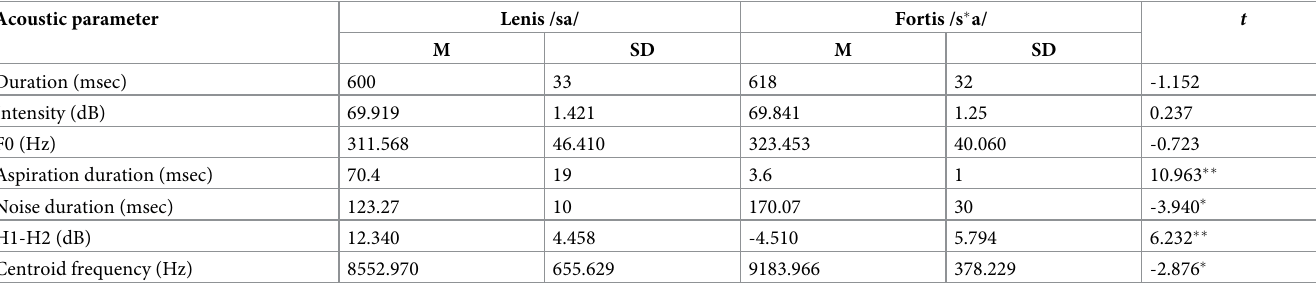
Table 1. Acoustic characteristics of Korean lenis versus fortis